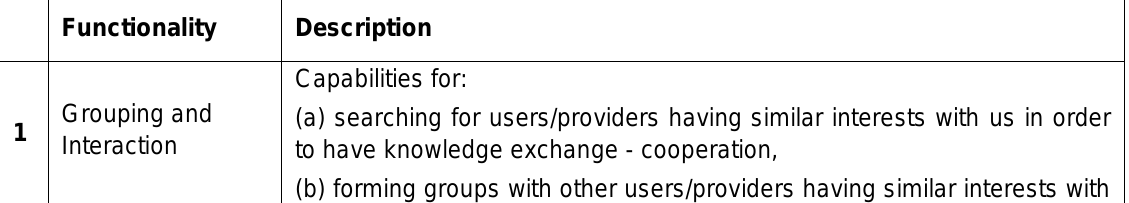
Table 2: Novel Web 2.0